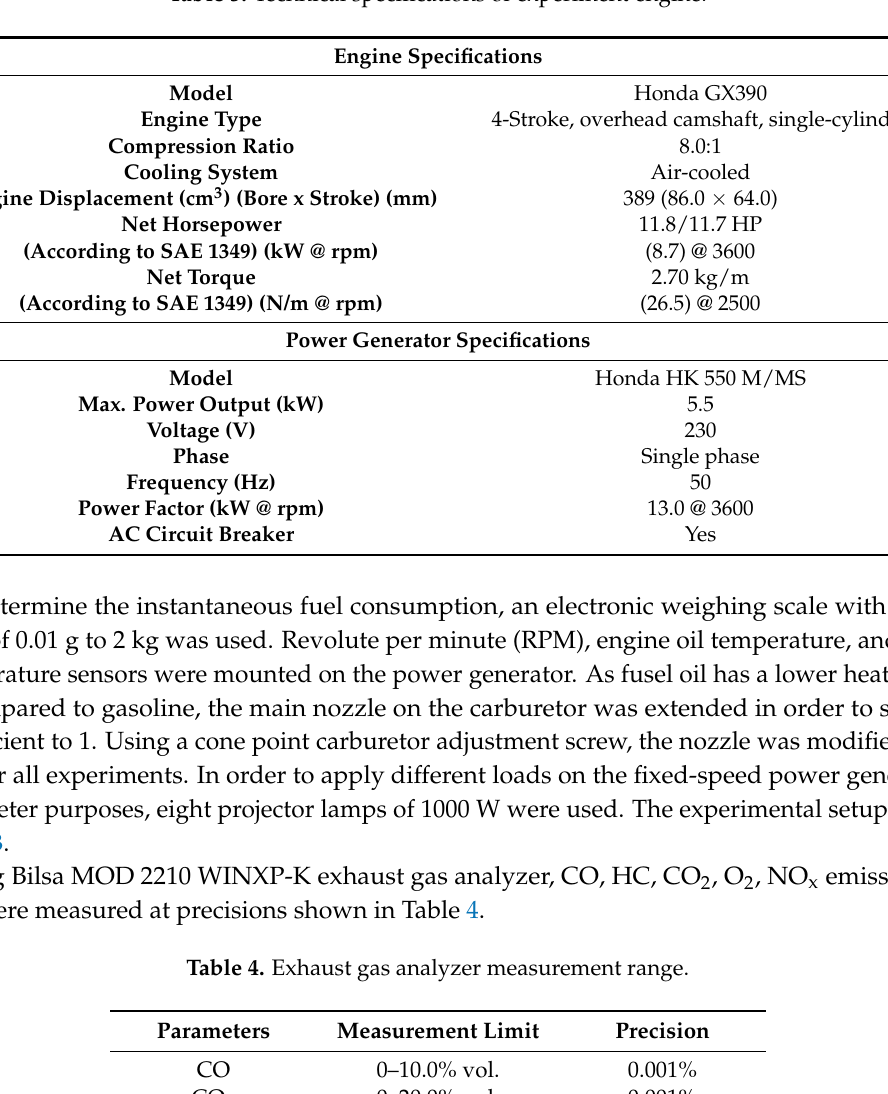
Table 3. Technical specifications of experiment engine.